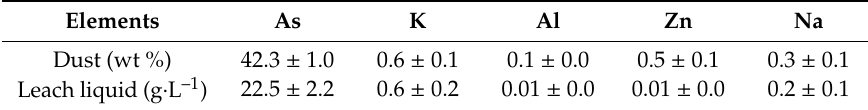
Table 1. Components of dust and leaching liquid (Data are provided as means +/ − scanning electron microscopy (SEM); n =